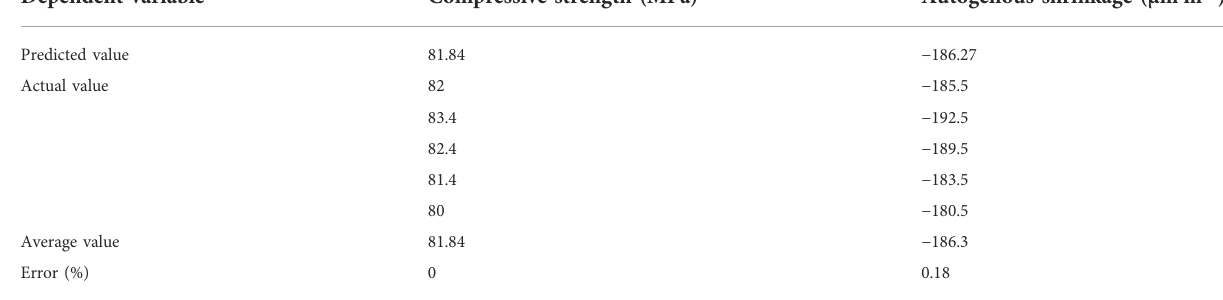
TABLE 7 Veri fi cation test results of response surface prediction